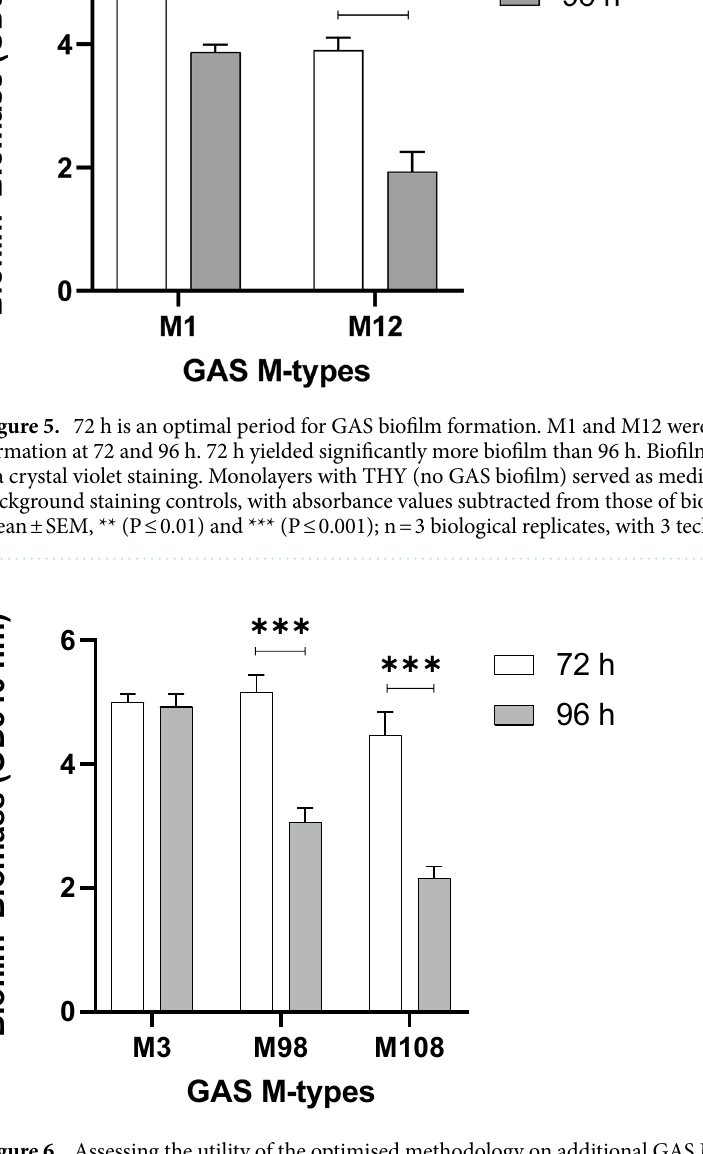
Figure 6. Assessing the utility of the optimised methodology on additional GAS M types (M3, 98, and 108). Biofilm biomass was determined via crystal violet staining. Monolayers with THY (no GAS biofilm) served as media sterility controls and background staining controls, with absorbance values subtracted from those of biofilm samples. Data represents mean ± SEM, ** (P ≤ 0.01) and *** (P ≤ 0.001); n = 3 biological replicates, with 3 technical replicates